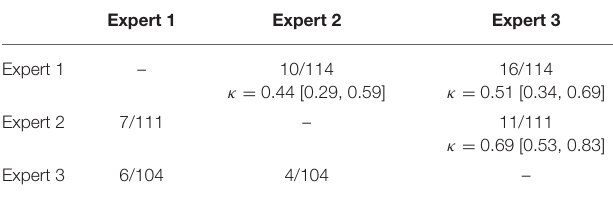
TABLE 3 | Inter-expert disparity during phase 2.